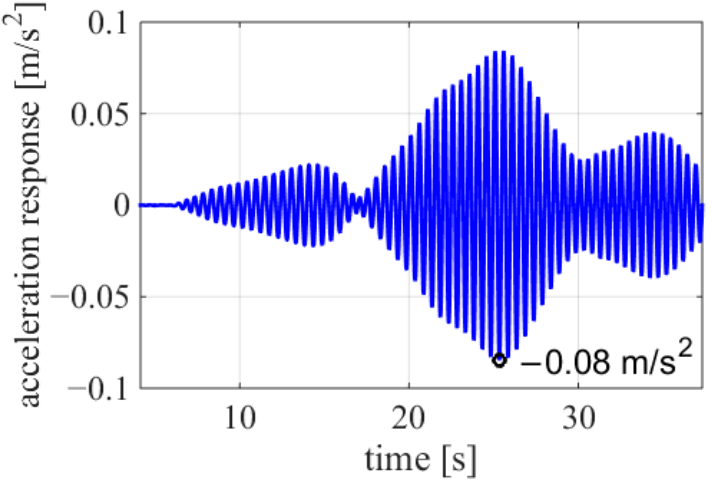
Figure 8. The time history of a representative single pedestrian-induced vibrations in the vertical (Z) direction at the midspan of the structure. The pedestrian is the one who arrives at 4.14 s and stops walking at 37.32 s when the simulation ends.